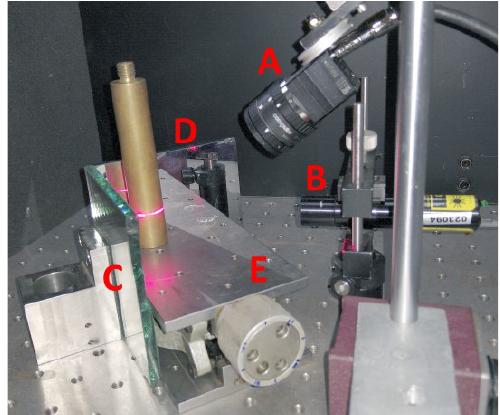
Figure 7: LTS system setup a) camera and lens, b) laser line projector, c) left and d) right first surface mirrors, and e) vertical translation table.